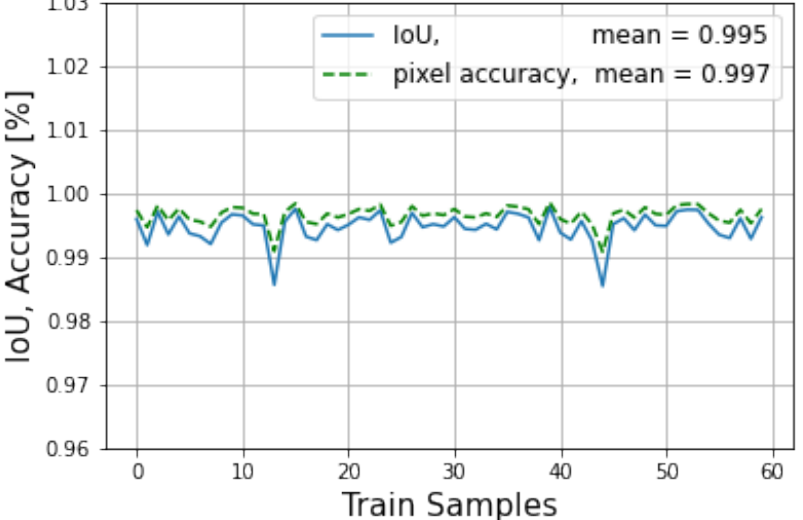
Figure 21. The IoU and pixel accuracy are shown for the training mode.